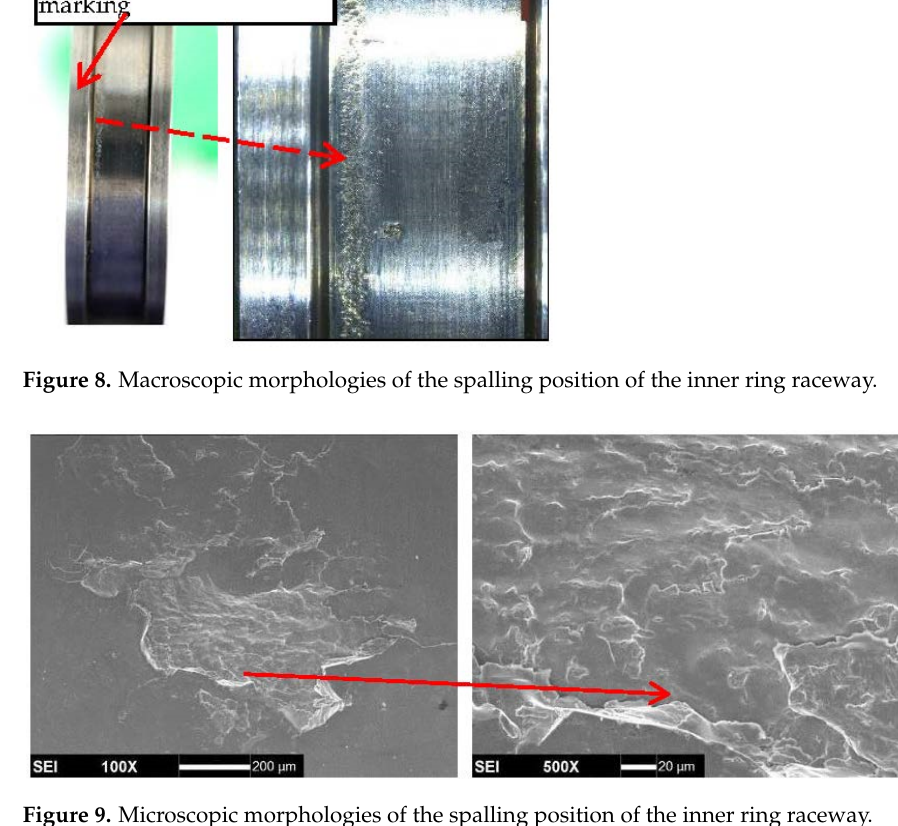
Figure 9. Microscopic morphologies of the spalling position of the inner ring raceway.